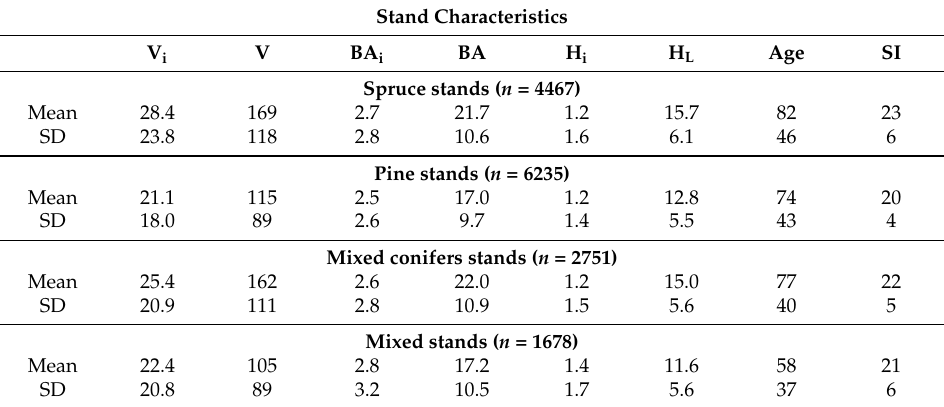
Table A1. Mean and standard deviation (SD) of some stand characteristics for the different forest types used in the modeling ( n = number of